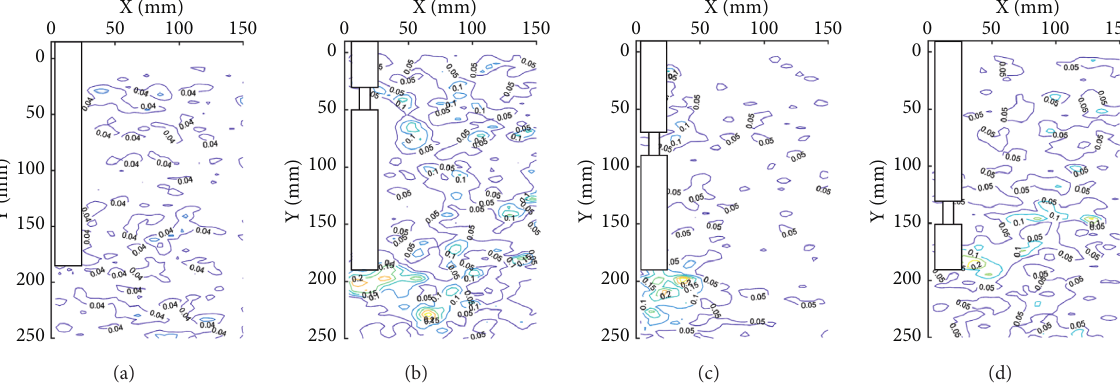
Figure 10: Displacement contour map of soil around the single pile under 220N load level. (a) Intact pile. (b) Necking in the shallow